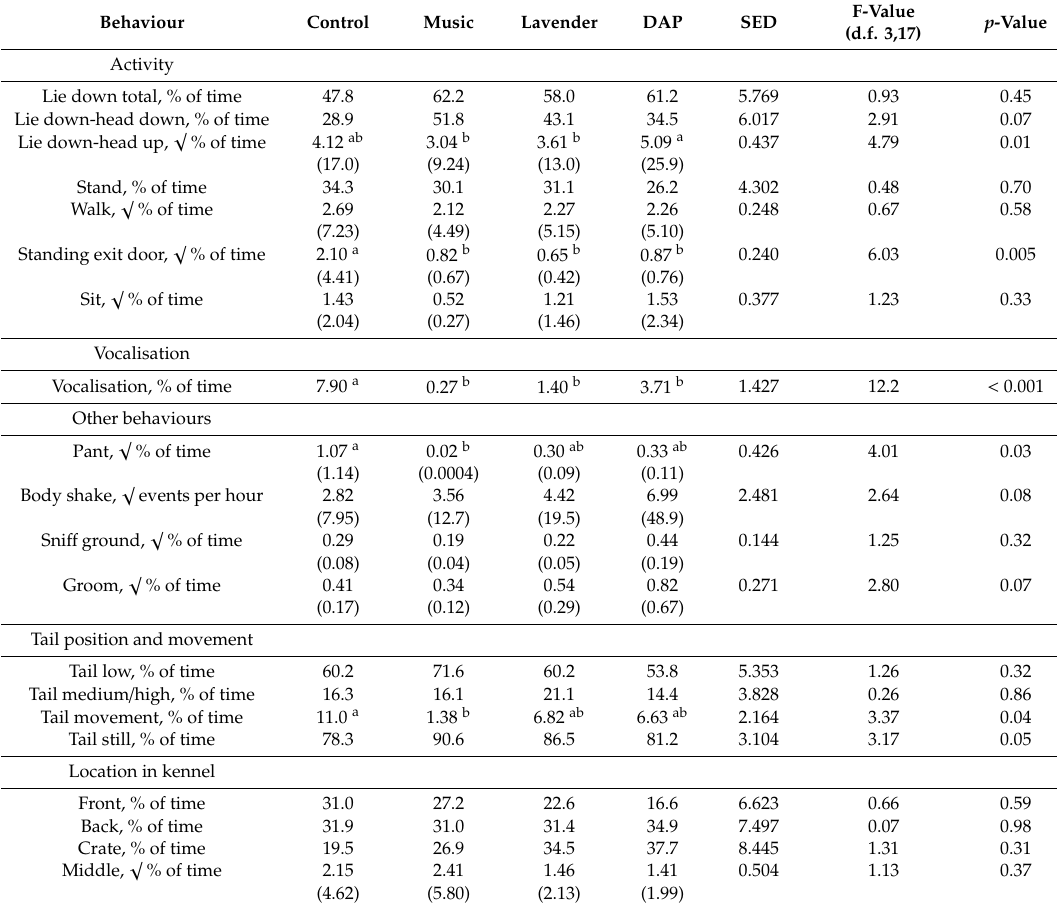
Table 3. The behaviour of a subset of dogs ( n = 34) exposed to lavender, music, DAP or a control treatment, during the 3 h treatment period on 5 consecutive days. For square root ( parameters, back transformed values are also reported in parentheses. Means that do not share a superscript letter are significantly di ff erent ( p < 0.05) by Tukey’s